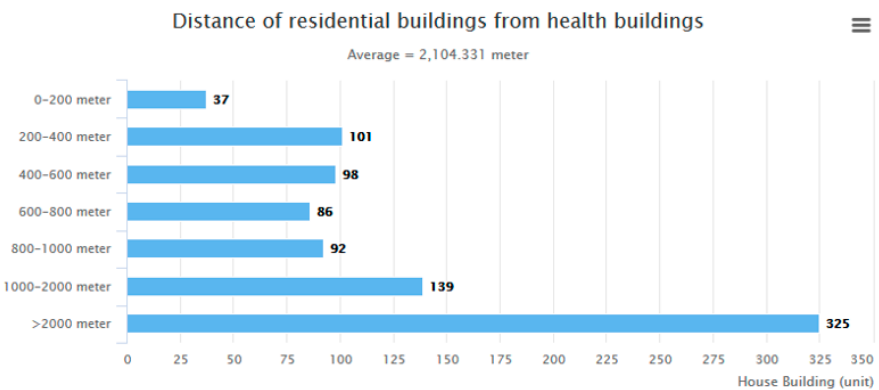
Figure 16. The average distance of residential buildings from health buildings.